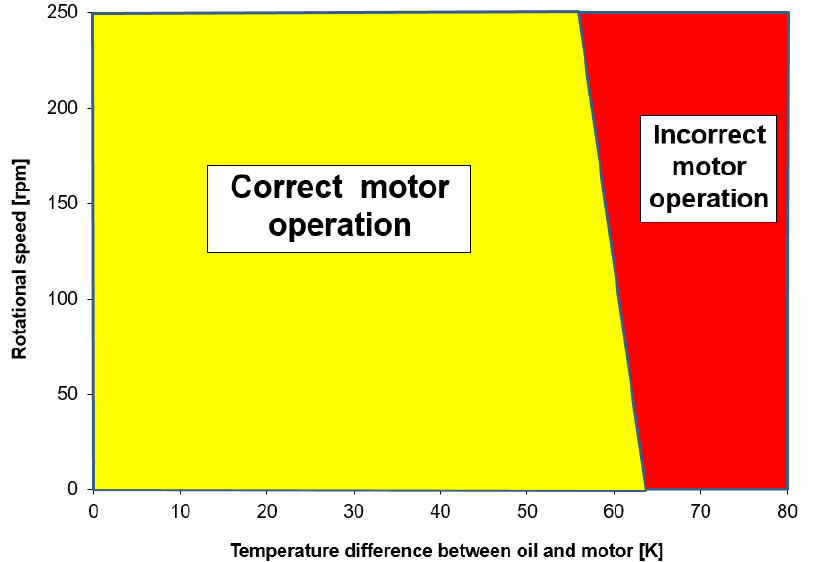
Figure 11. The areas of parameters of the correct and incorrect operation of the M1 unloaded motor with 23 μ m axial clearance when started in thermal shock